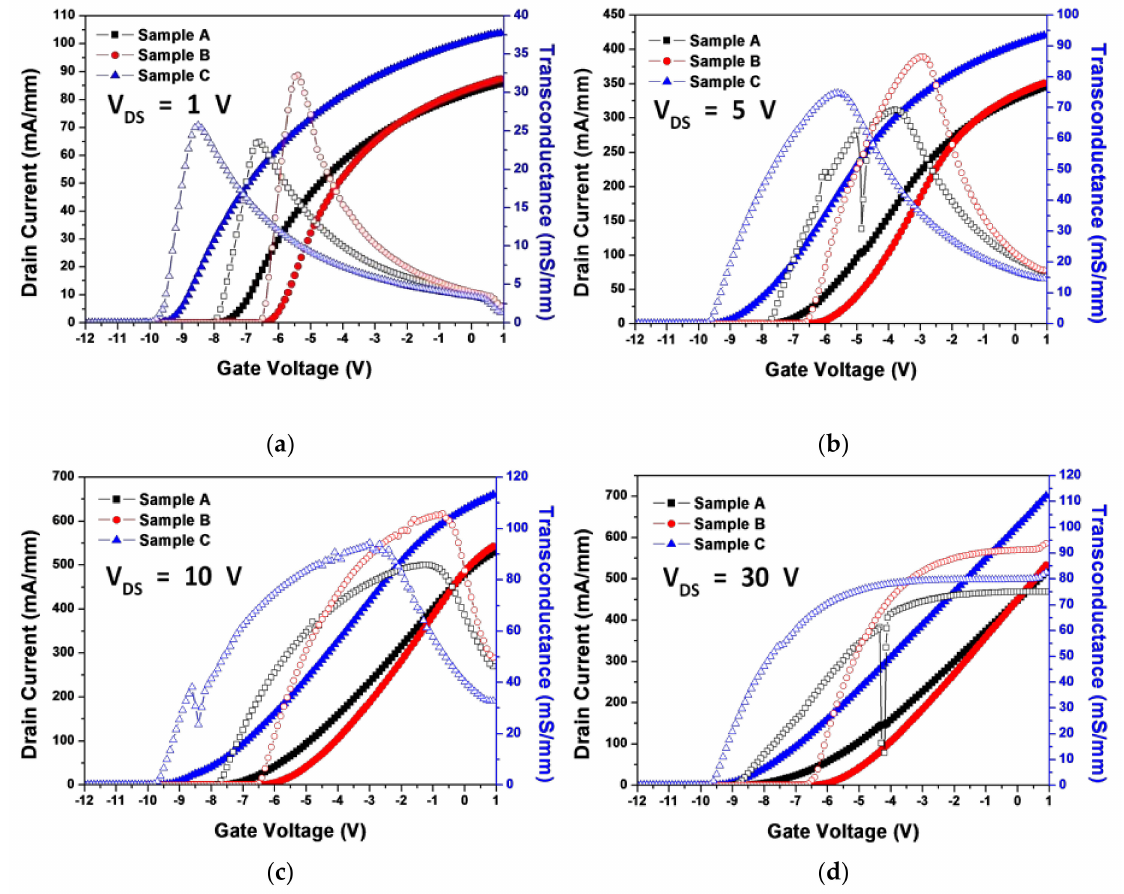
Figure 8. Comparison of transfer I–V characteristics of MIS-HEMTs (samples A, B, and C) with respect to V GS at ( a ) V DS = 1 V, ( b ) V DS = 5 V, ( c ) V DS = 10 V, and ( d ) V DS = 30 V (drain current (filled dot), transconductance (empty